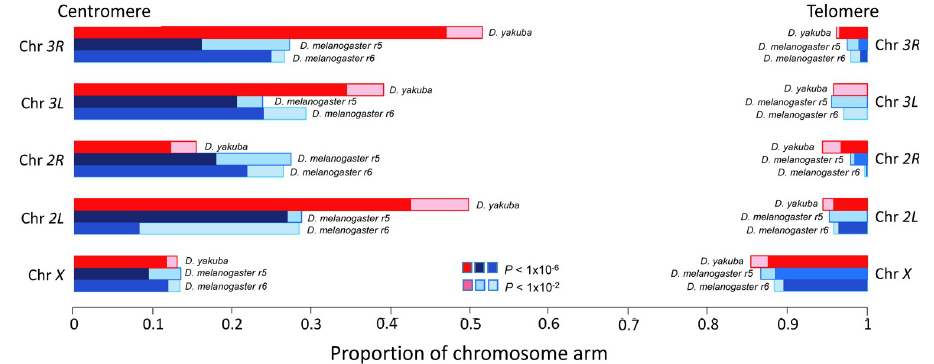
Fig 4. Centromere and telomere effects for different chromosome arms of D . yakuba and D . melanogaster . For D . melanogaster results are shown for genome r5.3 and r6 assemblies. The proportion of the chromosome with significant reduction in crossovers is based on the study of overlapping 1-Mb windows with increments of 100 kb. Two levels of significance are